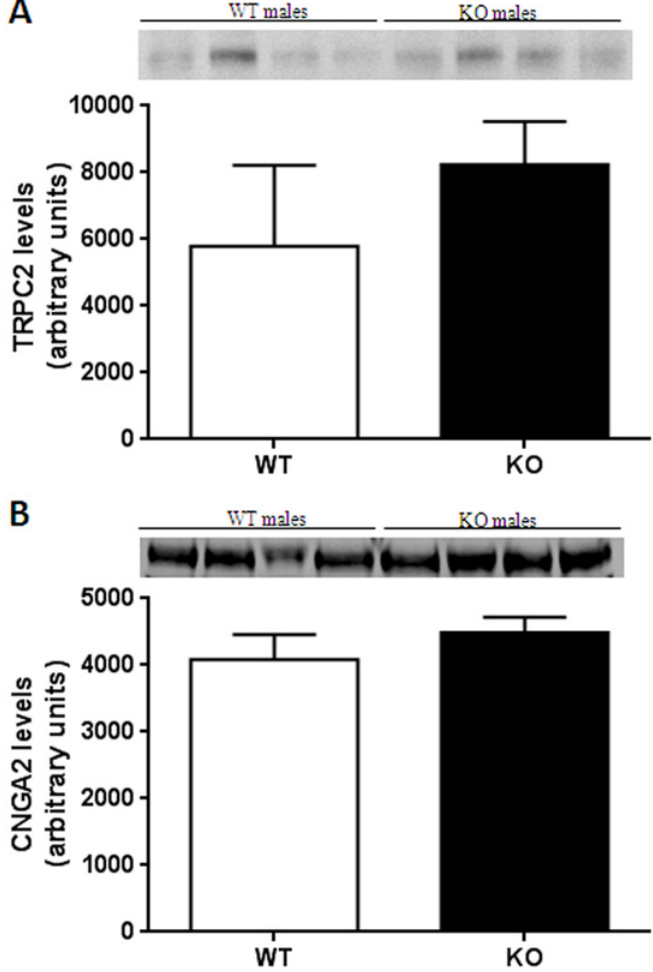
Fig 4. Expression levels of TRPC2 and CNGA2. (A) Immunoblot analysis of TRPC2 in VNO tissue from WT and KO male mice, (B) immunoblot analysis of CNGA2 in MOE tissue from WT and KO male mice. Expression levels of TRPC2 and CNGA2 were normalized to GAPDH levels. Data presented in the bar charts are expressed in arbitrary units and are the mean ± SEM for groups containing 5 – 6 WT and 4 – 5 KO males for each tissue. The insets above each bar chart are representative immunoblots for each